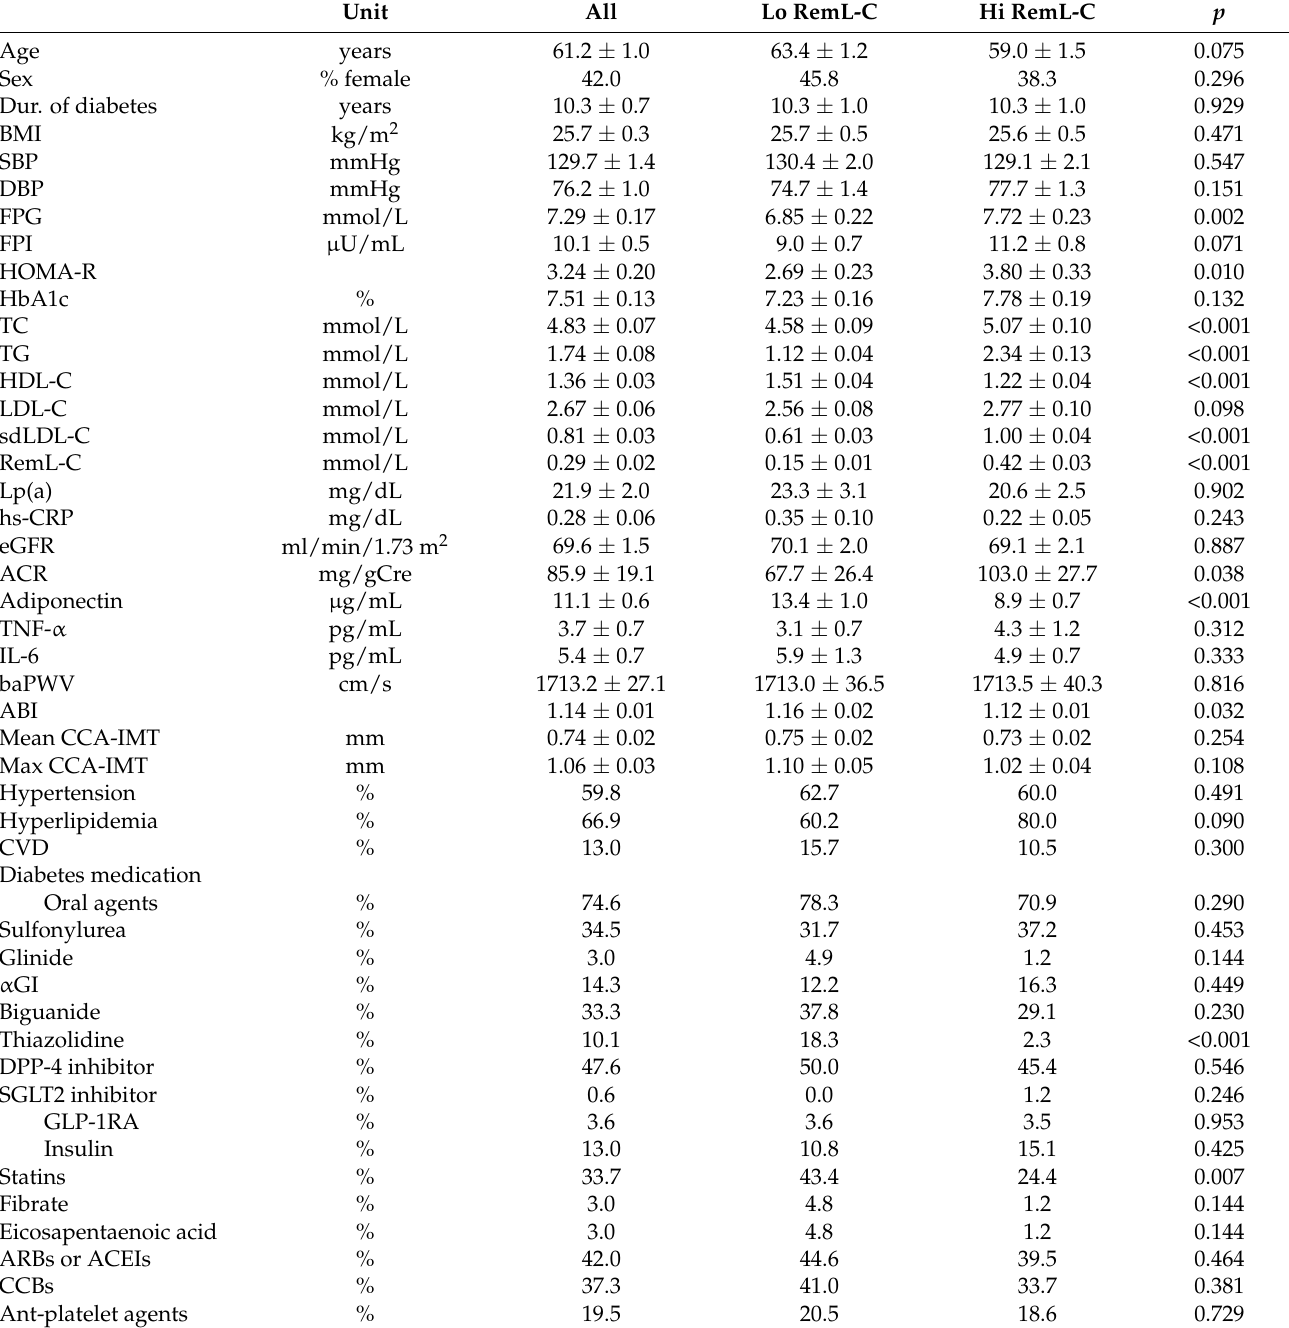
Table 1. Characteristics of the participants as a whole ( n = 169) and of those with lower (Lo RemL-C (<0.24 mmol/L): n = 83) or higher (Hi RemL-C ( ≥ 0.24 mmol/L): n = 86) RemL-C